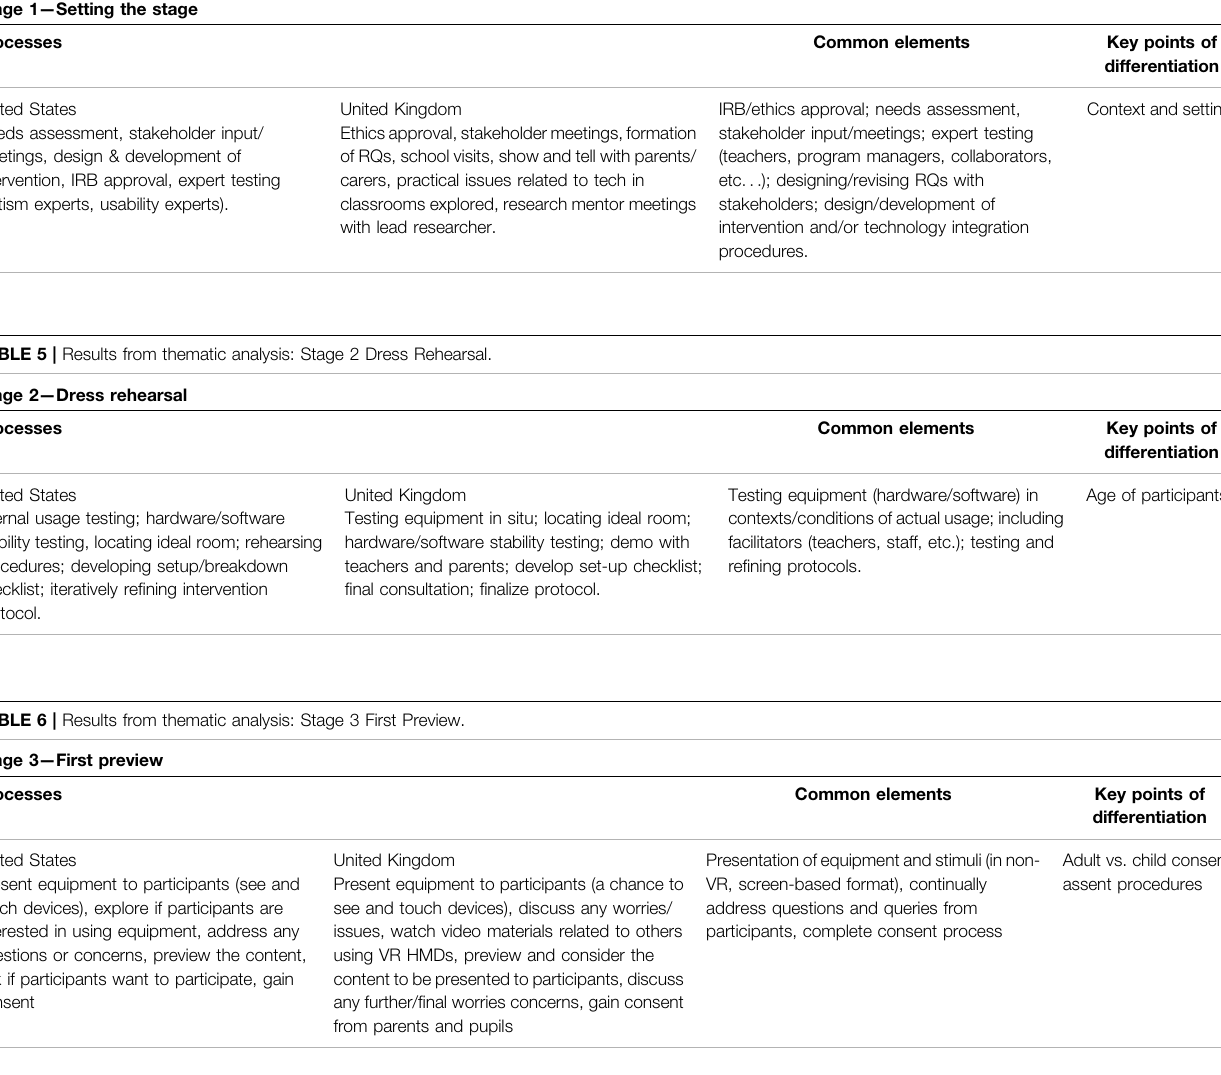
TABLE 4 | Results from thematic analysis: Stage 1 setting the stage. Stage 1 — Setting the stage